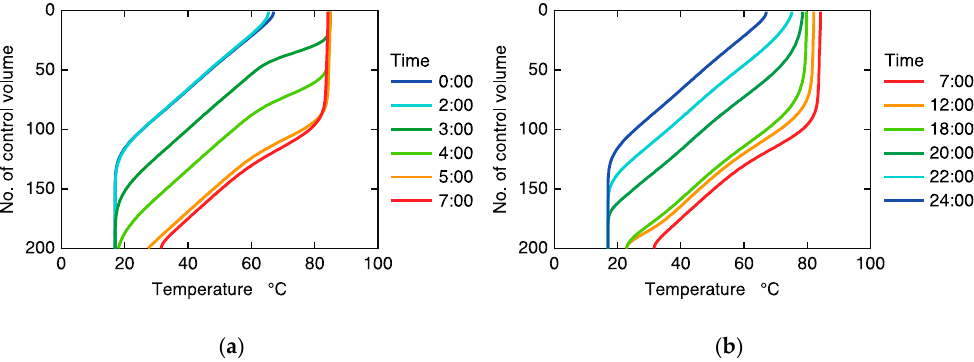
Figure 9. Changes in temperature distribution in storage tank for system U: ( a ) charging mode; ( b ) tapping mode.